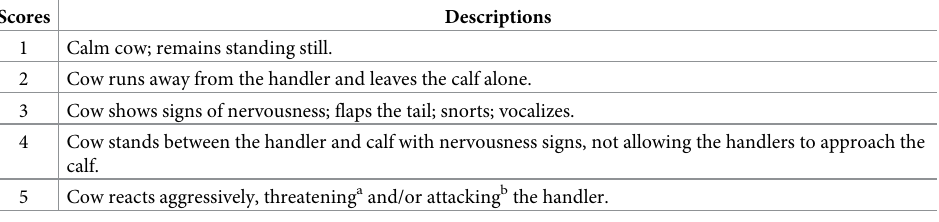
Table 2. Maternal Protective Behavior (MPB) score of Gyr cows at the first handling of their calves. Scores Descriptions 1 Calm cow; remains standing